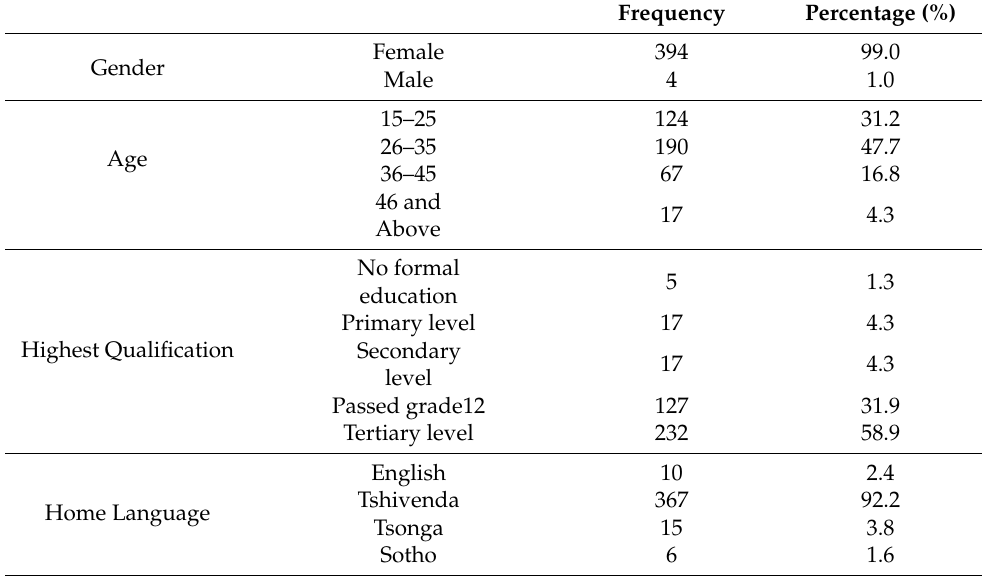
Table 1. Socio-demographic characteristics of